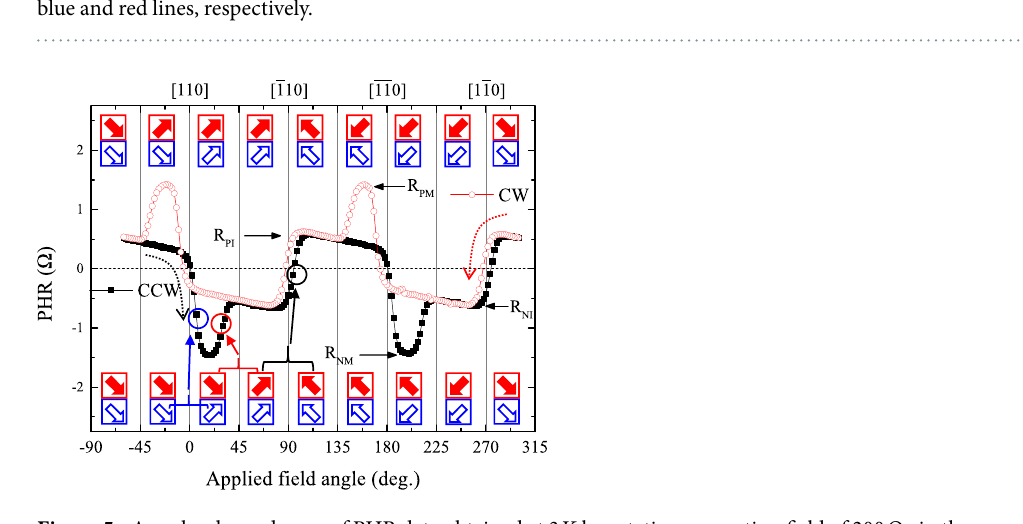
GaMnAs layer with positive Δ R . The angular positions at which these successive rotations occur are marked by arrows below the plots. This sequence of magnetization transitions for the two GaMnAs layers with opposite signs of Δ R is consistent with the larger (smaller) coercive fields for the GaMnAs layer with the positive (negative) sign of Δ R observed in field scan measurements shown in Figs 2 and 3. As the field direction passes 90° during CCW rotation, the PHR jumps abruptly to a positive value. This is a result of magnetization rotation from the 1 st to the 2 nd quadrant in both GaMnAs layers (see thick arrows at bottom of figure). The change in PHR for this simultaneous transition in the two GaMnAs layers is smaller than that caused by the transition in the single GaMnAs layer with negative Δ R , since it is a superposition of opposite contributions to PHR from GaMnAs layers with opposite signs of Δ R as the magnetization rotates from the 1 st to the 2 nd quadrant. Thus PHR reaches only an intermediate value (marked R PI ), which is a stable state with parallel orientations of magnetization in the trilayer, as indicated by thick arrows at bottom of the figure. When the field direction is further rotated CCW, past 180°, the GaMnAs layer with the negative sign of Δ R rotates first from the 2 nd quadrant to the 3 rd (open arrows), resulting in perpendicular alignment of magnetizations in the two magnetic layers. In this configuration the PHR of the trilayer reaches a minimum value, marked by R NM . The magnetization of the GaMnAs layer with the positive Δ R undergoes the same rotation at a slightly higher angle, resulting in an intermediate PHR value marked R NI . Finally, as the field orientation passes 270°, the magnetizations of both lay- ers again rotate together (from the 3 rd to the 4 th quadrant), returning to the initial configuration, as shown by the arrows (and thus returning to the PHR value of R PI ). Note further that, in the behavior just described, changes in PHR caused by the GaMnAs layer with nega- tive Δ R (e.g., the first jump right after 0°) are about twice as large as those caused by the layer with positive Δ R (e.g., the jump just below 45°) for the same rotation of magnetization over the [110] direction. Since the bottom